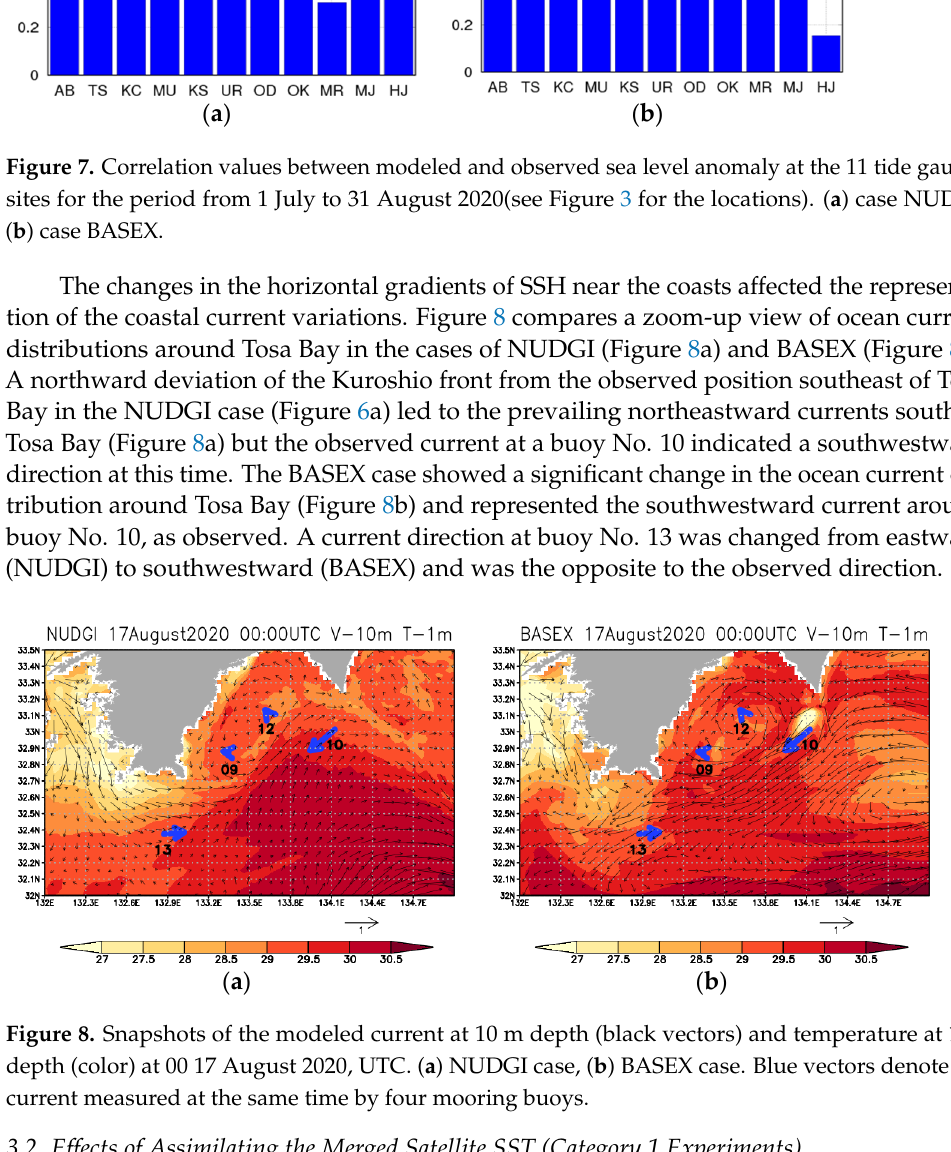
( b ) Figure 6. Daily mean modeled SSH on 17 August 2020. ( a ) NUDGI case, ( b ) BASEX case. Blue and black curves denote the locations of the modeled SSH = 0.3 m and observed Kuroshio positions, respectively. Comparison of Figure 6a,b further indicates the relatively smaller horizontal scale SSH patterns around the coasts of Japan, including insides of coastal bays (Figure 6a), were changed by applying the daily-basis DA (Figure 6b). Correlation values with the sea level anomaly data were higher at sites in the eastern part of the southern coasts